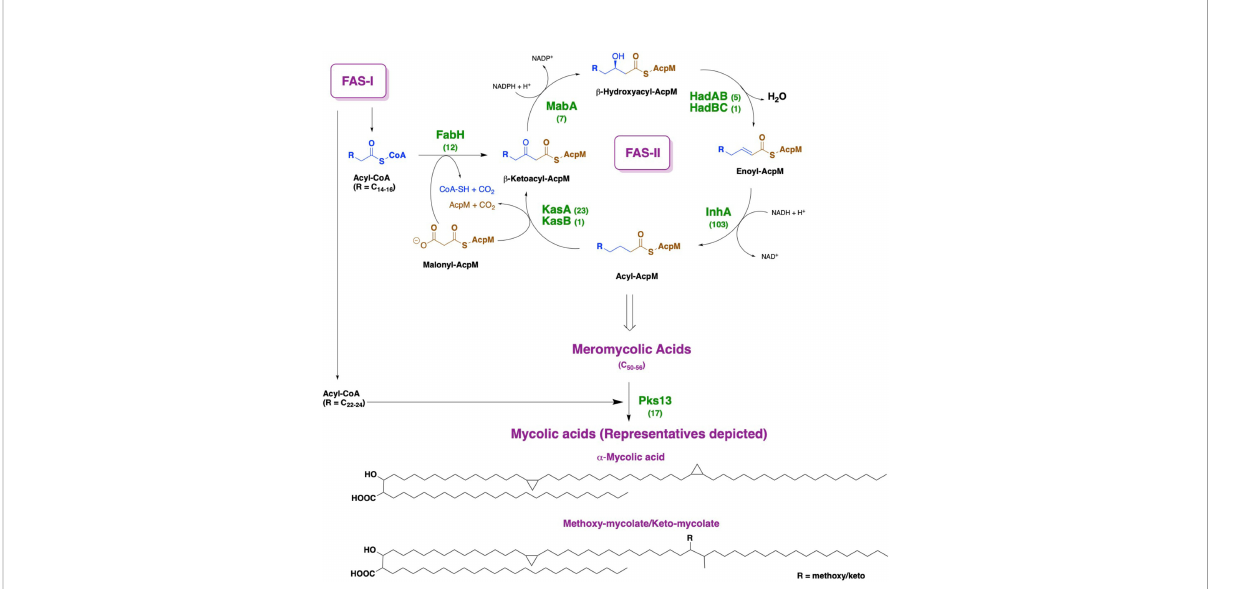
FIGURE 1 Depiction of mycolic acid biosynthesis through the FAS-I and FAS-II pathways. AcpM: mycobacterial acyl carrier protein. By each protein name, the number of corresponding X-ray crystal structures deposited in the Protein Data Bank is